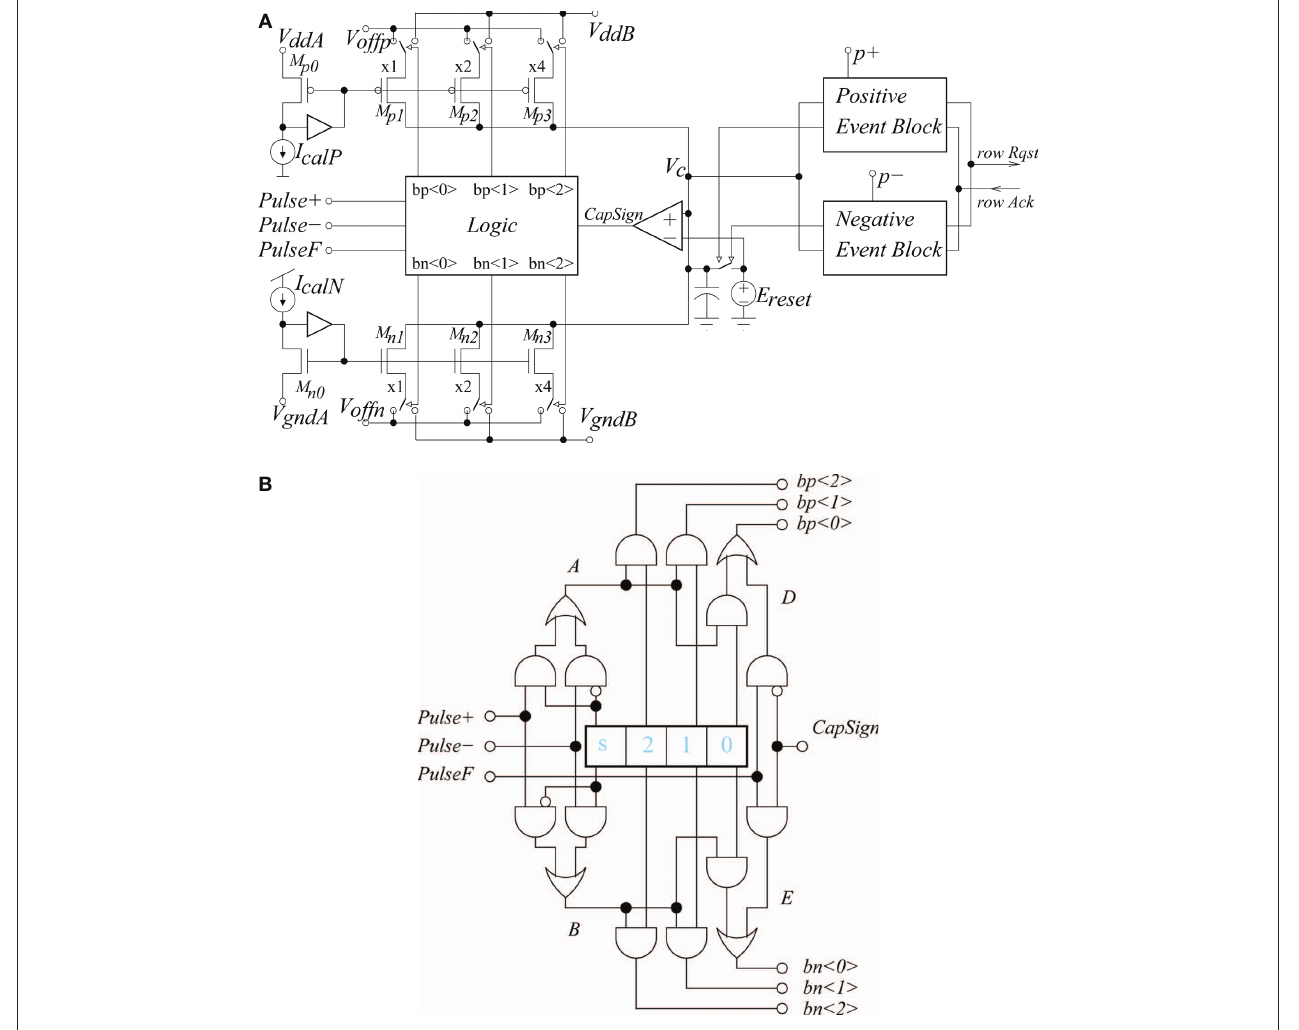
FIgure 20 | (a) Digitally weight-modulated and calibrated charge packet driven leaky I&F neuron schematic. The neuron handles positive and negative charge packets to emulate excitatory and inhibitory synapses, and has input for a periodic global signal PulseF to implement a programmable constant rate leak. Neuron can deliver positive or negative output events. (b) Detail of logic block in